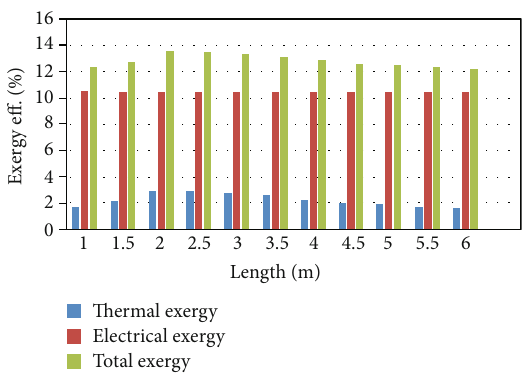
Figure 5: The e ff ect of length change on exergy e ffi